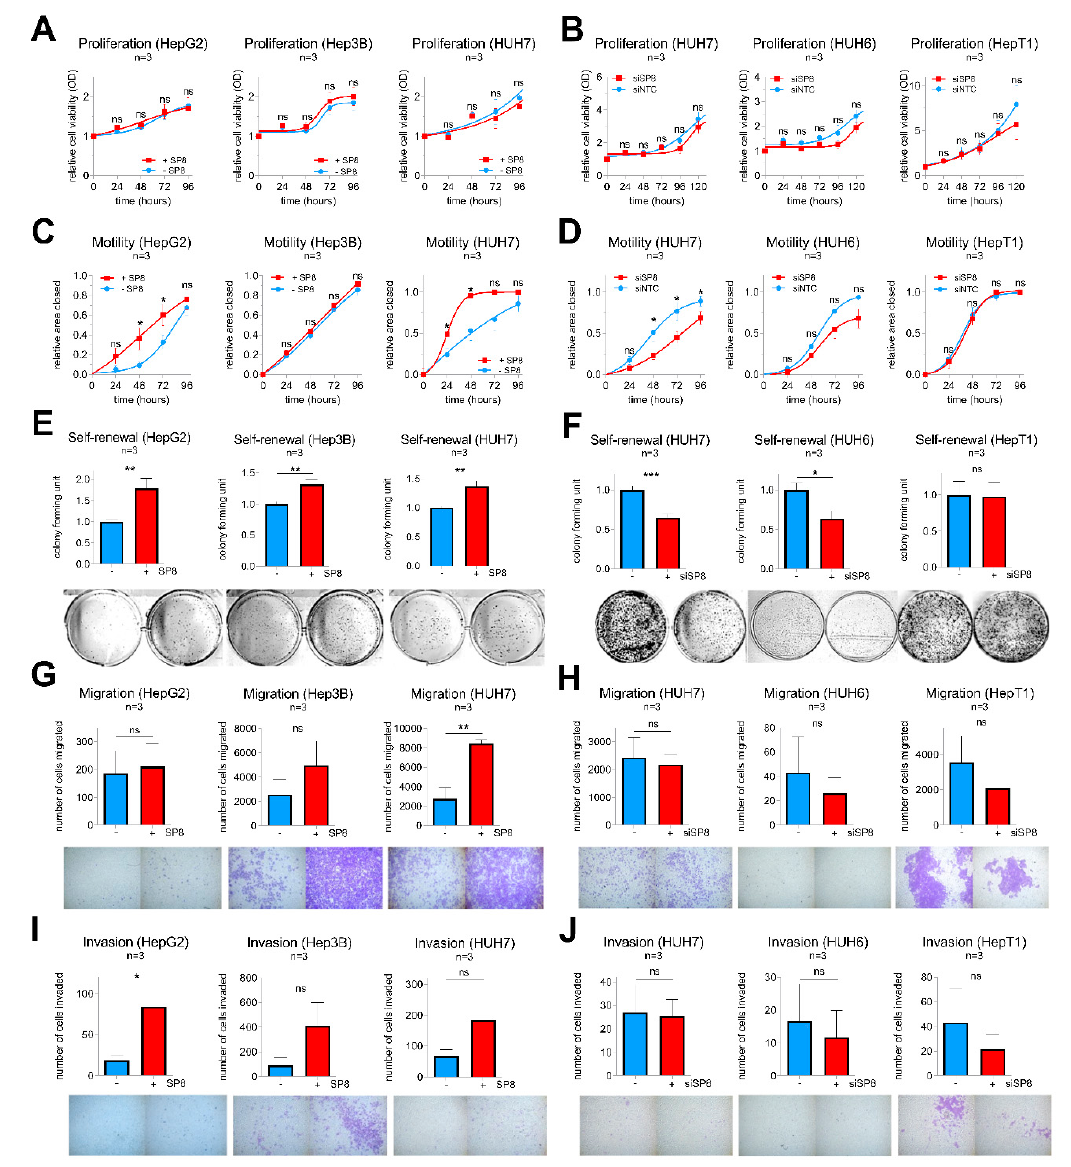
Figure 5. Gain ‐ and loss ‐ of ‐ function studies in liver cancer cell lines after transfection with either ( A , C , E , G , I ) an empty control vector ( − SP8) and a SP8 cDNA containing expression plasmid (+SP8), or ( B , D , F , H , J ) non-targeting siRNAs (siNTC) and a siRNA directed against SP8 (siSP8), respectively. ( A , B ) Cell proliferation was measured at the indicated time points using MTT assays. ( C , D ) Cell motility was determined in scratch assays at the indicated time points. ( E , F ) Self-renewal was determined by counting colonies 10 days after transfection. Representative images of cell assays are shown below the graphs. ( G , H ) Migration was measured by counting cells that migrated through pores of Boyden chambers without matrigel coating 48 h after transfection. ( I , J ) Invasion was measured by counting cells that migrated through pores of Boyden chambers coated with matrigel 72 h after transfection. Means ± SEM were calculated from the indicated number of independent experiments. Statistical significance of all experiments was calculated using Mann–Whitney (* p < 0.05, ** p < 0.01, *** p < 0.001).